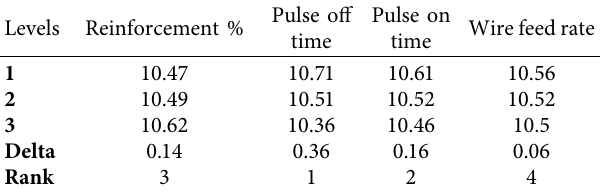
Figure 6: Effect of machining parameters on kerf width. Table 5: Response table for kerf width.